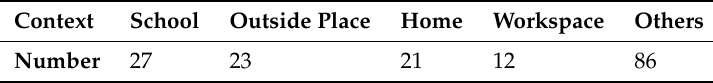
Table 4. User context of tangible light in the review results.